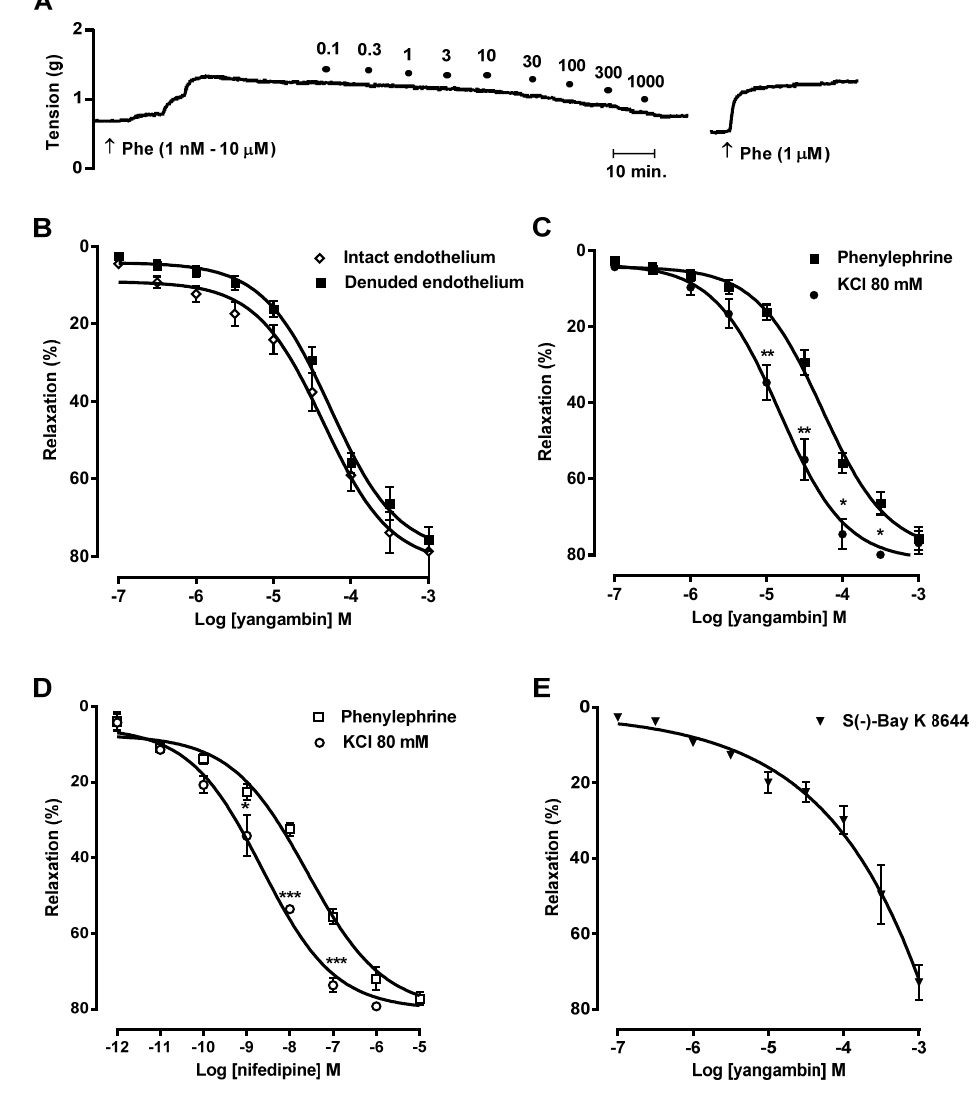
Figure 4. Vasorelaxant effect of yangambin on rat superior mesenteric arteries. ( A ) A typical tracing of the vasorelaxant effect of yangambin on endothelium-denuded arterial ring. Circles indicate the point at which the concentrations of yangambin (µM) were administered. ( B ) Concentration-response curves to yangambin (0.1 µM–1 mM) in rat mesenteric superior artery rings with intact-endothelium (  , n = 9) or denuded- endothelium (  , n = 7), pre-contracted with phenylephrine (1 nM–10 µM). ( C ) Comparison of the vasorelaxing effects of yangambin in endothelium-denuded rings between phenylephrine (1 nM–10 µM) (  , n = 7) or KCl (80 mM) (  , n = 7)-induced contractions. ( D ) Comparison of the vasorelaxing effects of nifedipine (1 pM–10 µM) in endothelium-denuded rings between phenylephrine (1 nM–10 µM) (  , n = 7) or KCl (80 mM) (  , n = 7)-induced contractions. ( E ) Vasorelaxant effect of yangambin in mesenteric arteries pre-contracted with the voltage-gated Ca 2+ channels activator S( − )-Bay K 8644 (200 nM) (  , n = 7). Results are expressed as mean ± S.E.M. * p < 0.05 vs. phenylephrine, ** p < 0.01 vs.